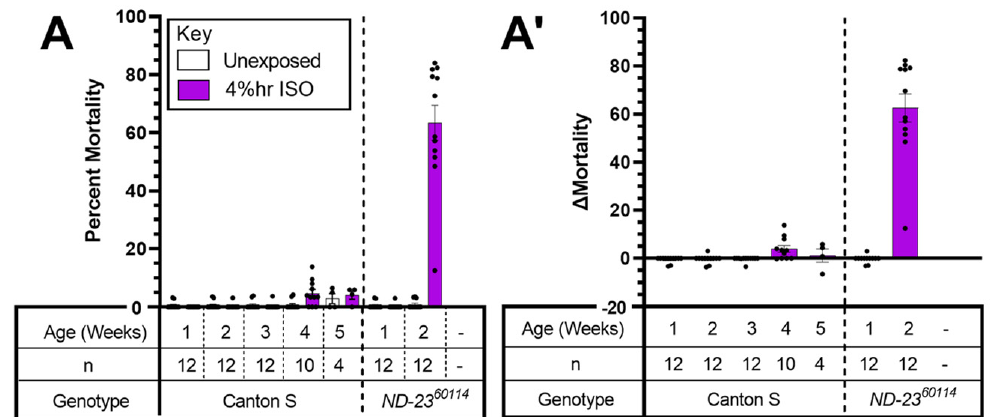
Figure 2. AiN in ND-23 60114 flies is age-dependent. Groups of flies were exposed for two hours to 2% ISO in 75% O 2 at weekly intervals. Mortality was determined 24 h after exposure. No mortality attributable to anesthetic exposure was observed in Canton S flies while ND-23 60114 experienced an abrupt increase in mortality at two weeks of age ( A ). ( A’ ): same data as A with control mortality subtracted ( ∆ Mortality). Each dot represents a biological replicate of 15–35 mixed-sex flies. Results are presented as mean ± SEM. Dashes indicate that the experiment was not performed because there were fewer than three vials of 15 flies. Table 1. Complex I alleles screened for hyperoxic ISO toxicity. BDSC: Bloomington Drosophila Stock Center.